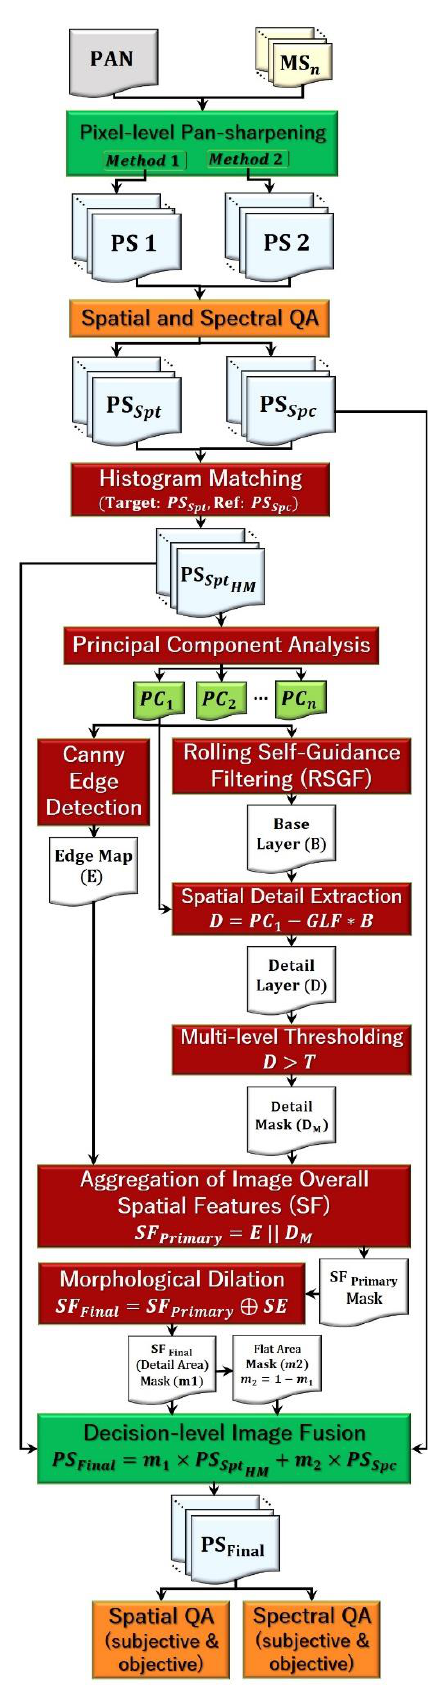
Figure 1. Flowchart of the proposed decision-fusion